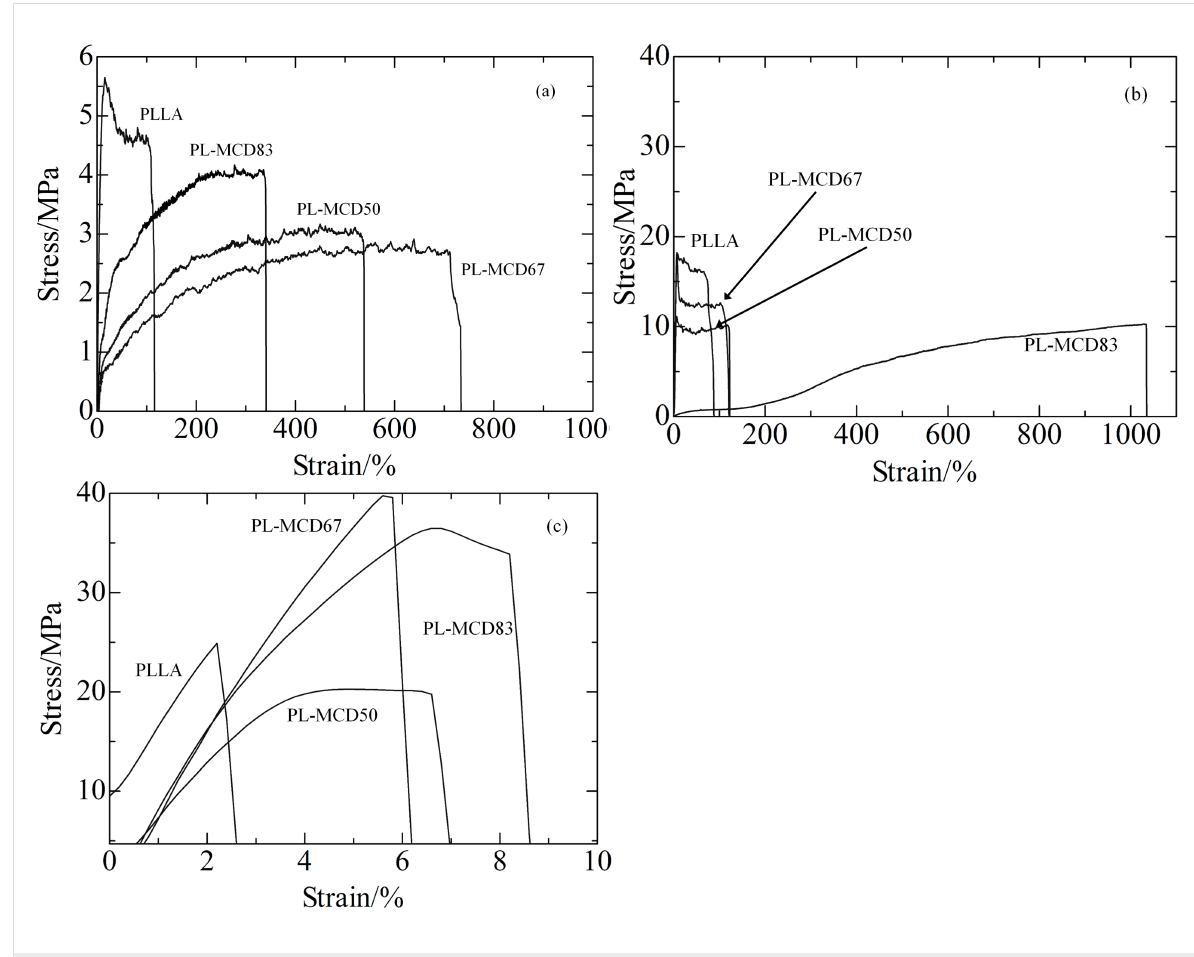
Figure 4: Stress-Strain curve for PLLA, PL-MCD50, 67 and 83 at a) 100 °C, b) 60 ˚ C and c) 25 °C.